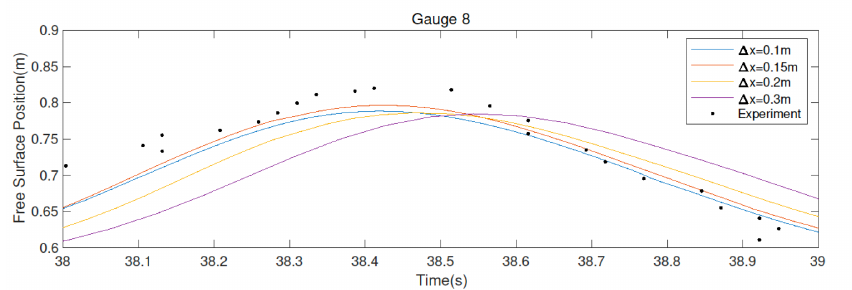
Figure 5. Grid convergence based on the surface elevation at WG8.